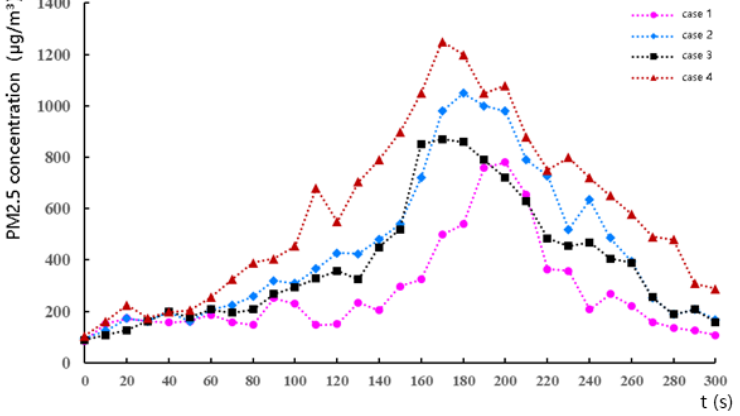
Figure 7. Variation in PM2.5 concentration for 4 cases in breathing zone in the kitchen.